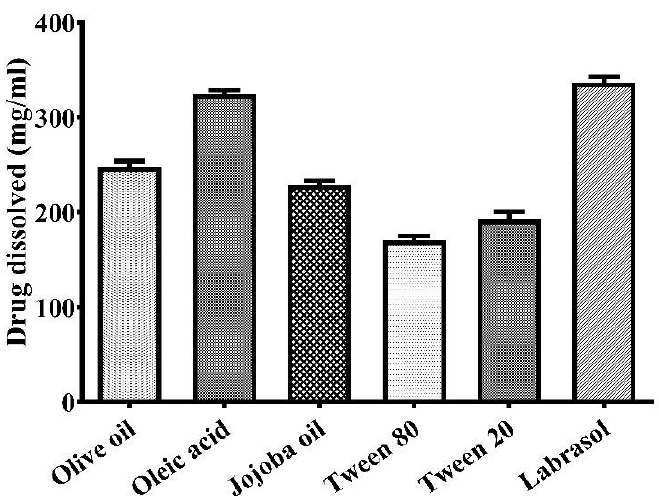
Figure 1. Solubility of lidocaine in various excipients. Data submitted as mean ± SD ( n =